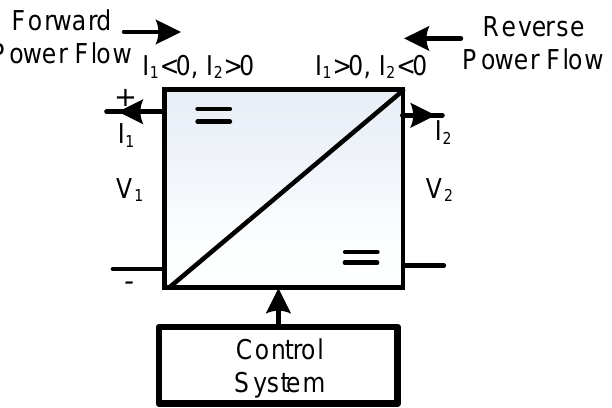
Figure 2. Structure of Bidirectional DC-DC converters (BDC).